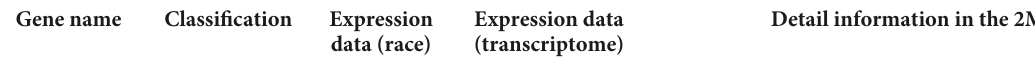
TABLE 3 The information about MHC-IIB genes in Chinese